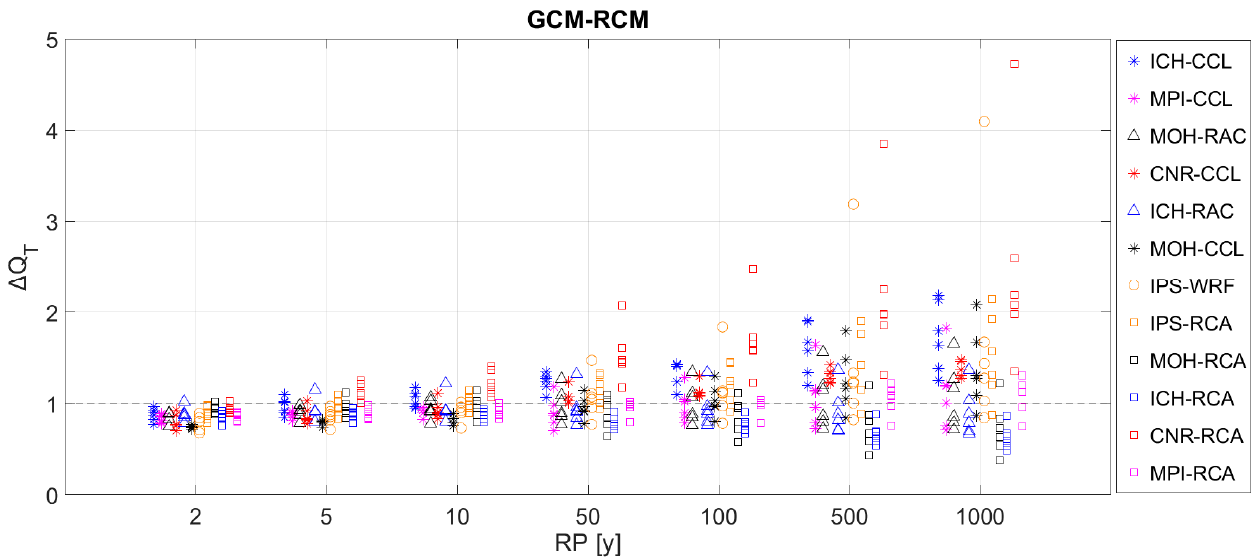
Figure 11. Median values of Δ Q T for each combination of GCM and